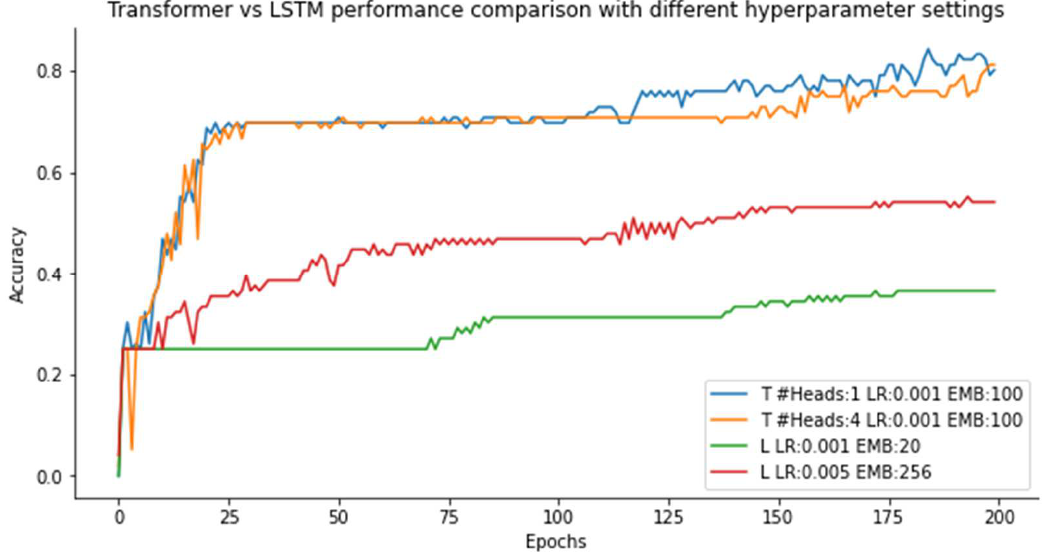
Figure 8. Transformer-based VS LSTM-based models performance comparison with different hyperparameters settings. Accuracies of transformer-based models are significantly better than accuracies of LSTM-based models. Table 2. Selected hyperparameters for tuning while training the two proposed models.